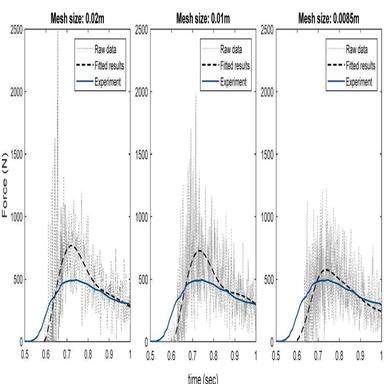
Impact of the element size on the numerical data.